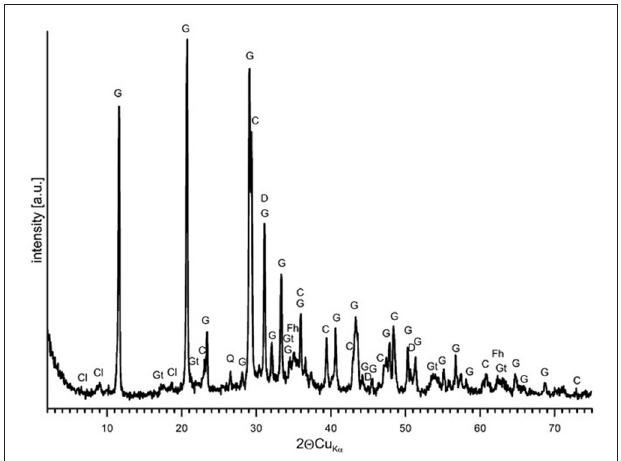
FIGURE 4 | Thermal patterns (DTA–TG–DTG) and QMS signals (not to scale) of the gBIOs. The numbers denote temperatures of